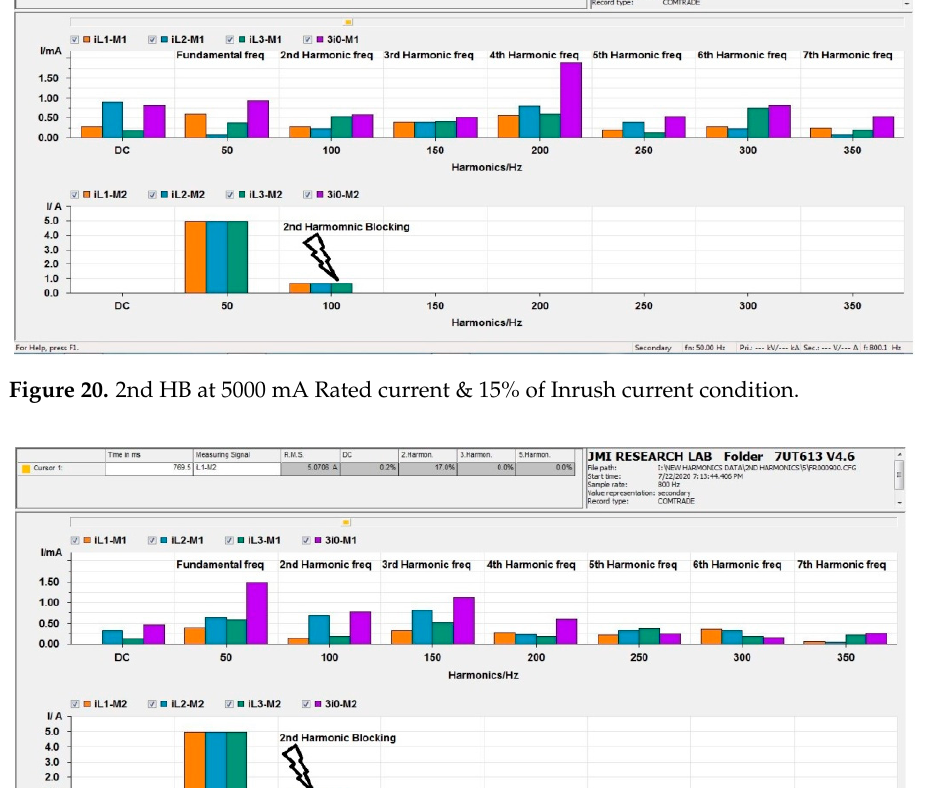
Figure 19. 2nd HB at 4000 mA Rated current & 20% of Inrush current condition.